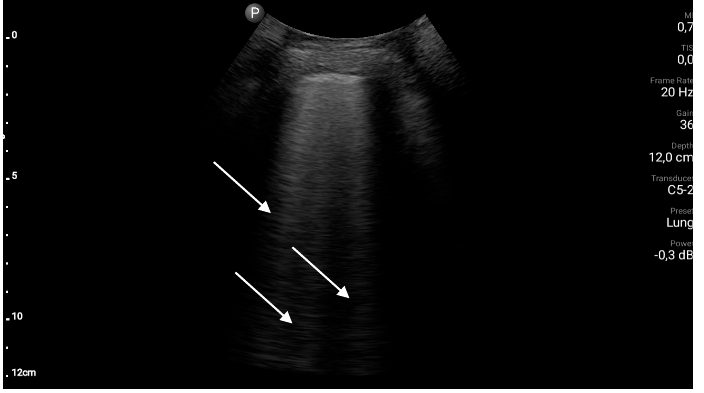
Figure 4. B-line artefacts (white arrows).